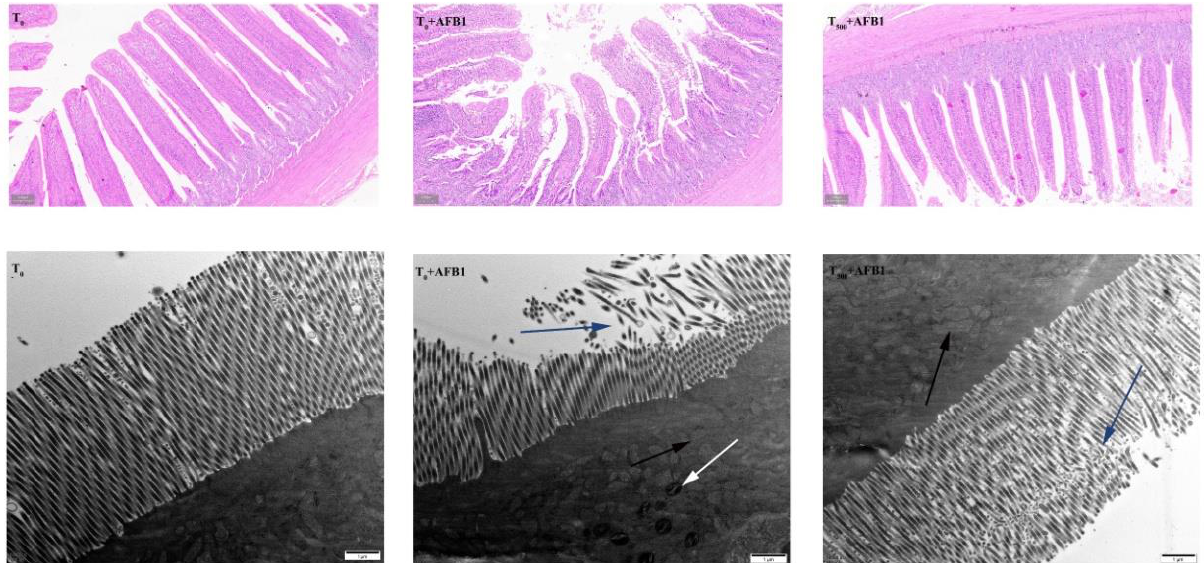
Figure 1. Ileum histopathological examination and scanning electron microscope of ducks ( Anas PlatyrhynchosI ) exposed to AFB1 at 70 days. The black arrowhead indicated swollen mitochondria, the white arrowhead indicated the shrinkage of mitochondrial and the blue arrowhead indicated broken of intestinal microvilli. T 0 : the control group, T 0 + AFB1: AFB1 group; T 500 + AFB1: curcumin + AFB1